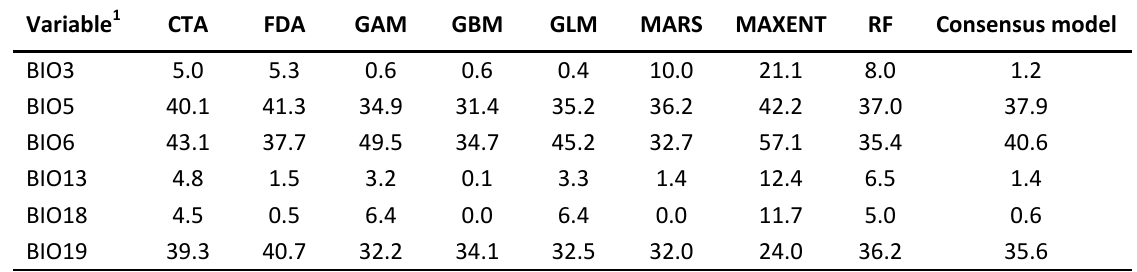
Table 3. Mean importance (%) of environmental variables for each of the modelling algorithms used in Bio- mod2 and for the consensus